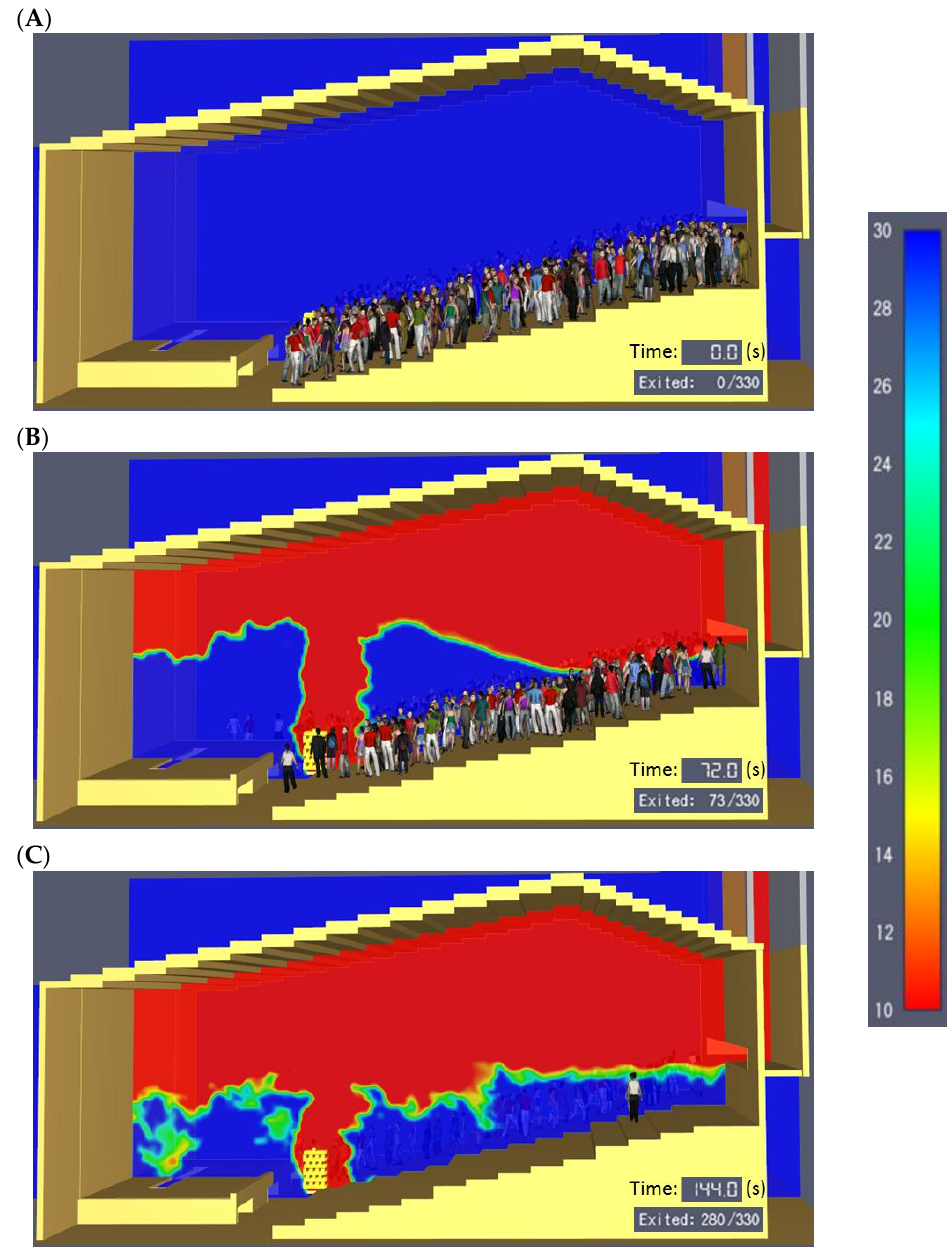
Figure 9. People evacuation situation for Case F_ORG (A) time = 0 s, (B) time = 72 s, (C) time = 144 s Color scale on the right indicates the visibility. The exited number in the lower right corner of each figure represents the number of people have left this room. The occupancy capacity is 330 persons according to the official information.